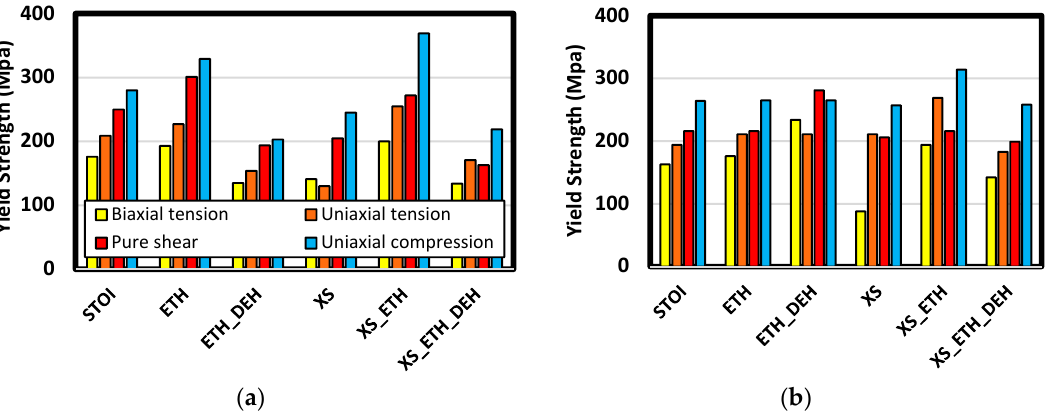
Figure 17. Comparison of yield strength among various stress states. Charts ( a ) and ( b ) are results for short- and long-chain systems, respectively.